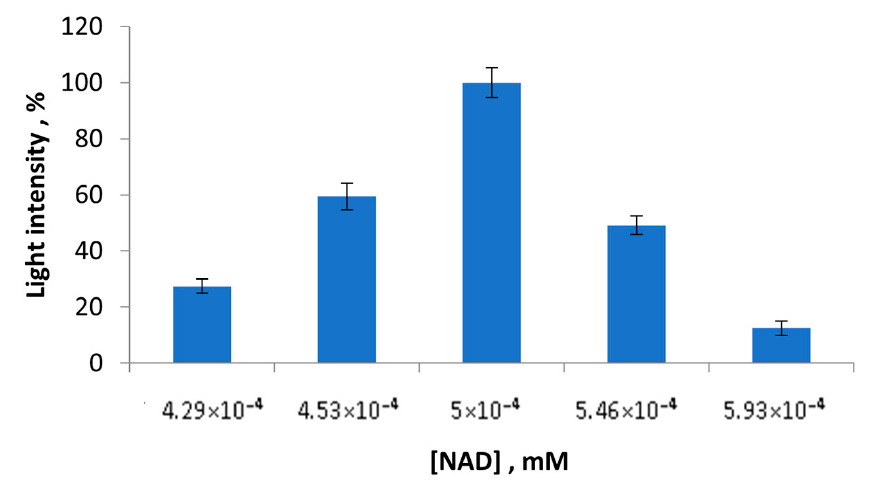
Figure 3. Values of light intensity of the LDH + Red + Luc enzyme system upon the NAD + concentration variation.